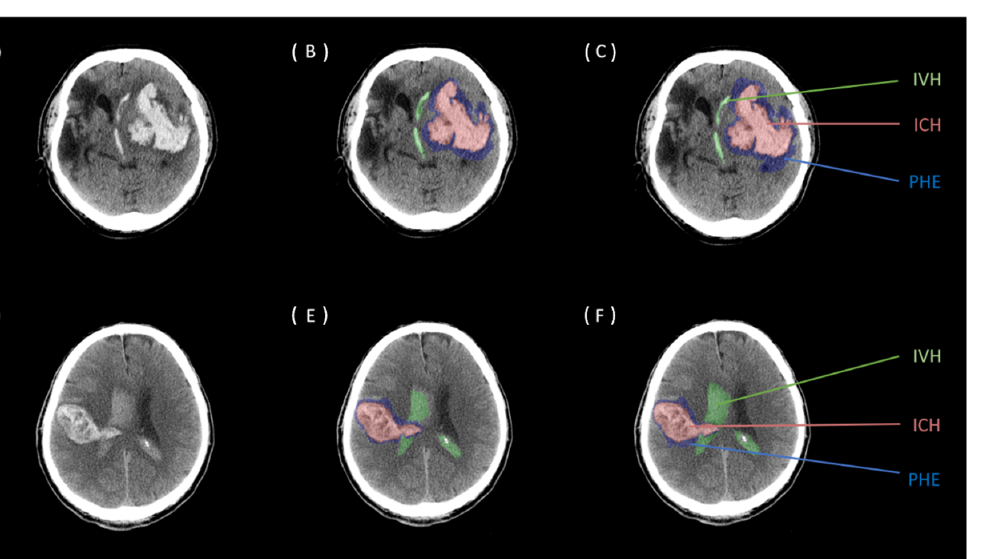
Figure 3. Two representative cases of high and low interrater agreement comparing two different segmentations of two raters across two separate readings. Two representative cases of interrater agreement for the segmentation of intracerebral hemorrhage (ICH; red), perihematomal edema (PHE; blue), and intraventricular hemorrhage (IVH; green) across two separate readings of two rater. ( A – C ): Above case representing high agreements with corresponding NCCT scan ( A ), first reading ( B ) and second reading ( C ). ( D – F ): Below case representing low agreements with corre- sponding NCCT scan ( D ), first reading ( E ) and second reading ( F ). ICH indicates intracerebral hem- orrhage; IVH, intraventricular hemorrhage; PHE, perihematomal edema.